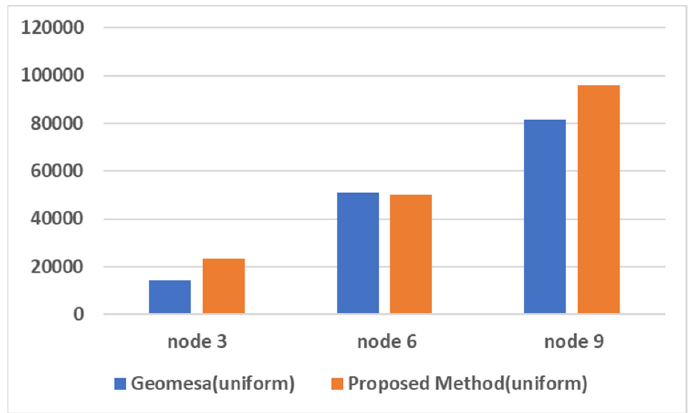
Figure 11. Range query throughput of Geomesa and the proposed method (Range query throughput: number of range queries per second). number of range queries per